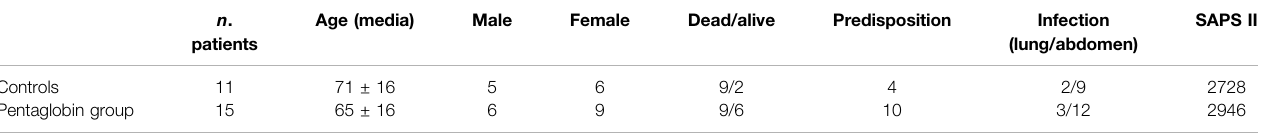
TABLE 1 | Patients ’ characteristics and Predisposition, Infection/injury type, Response and Organ dysfunction (PIRO) score. The PIRO score includes eight variables, each given the same weight (Age, Comorbid conditions, Leukopenia, Hypothermia, Cardiovascular dysfunction, Respiratory dysfunction, Renal dysfunction, Central nervous system dysfunction).